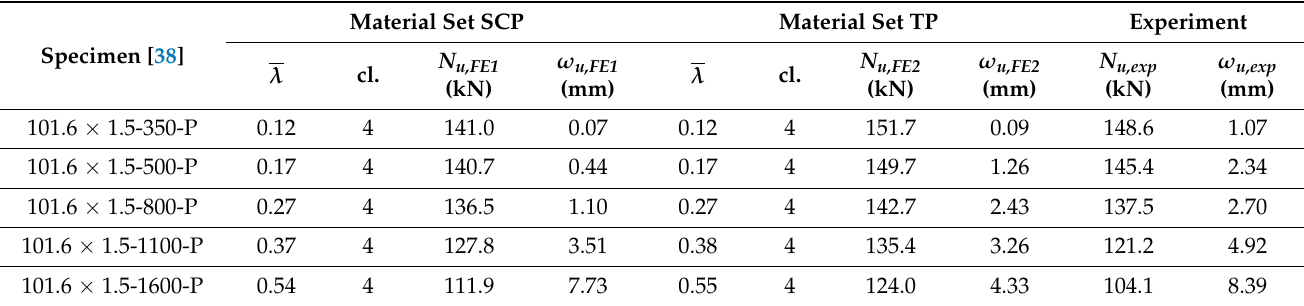
Table 12. Approach #A, FEA, and experiment results of the cross-section set 101.6 × 1.5 CHS pin-ended columns.